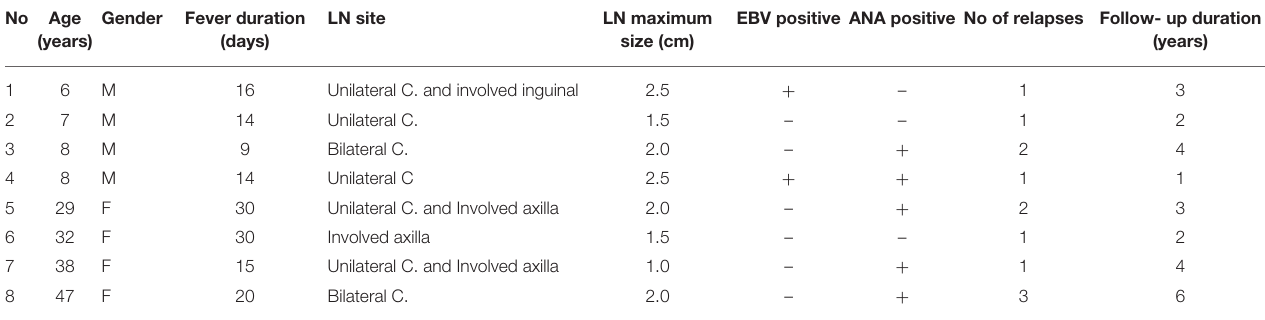
TABLE 4 | Kikuchi-Fujimoto disease patients with relapse. No Age Gender Fever duration (years)